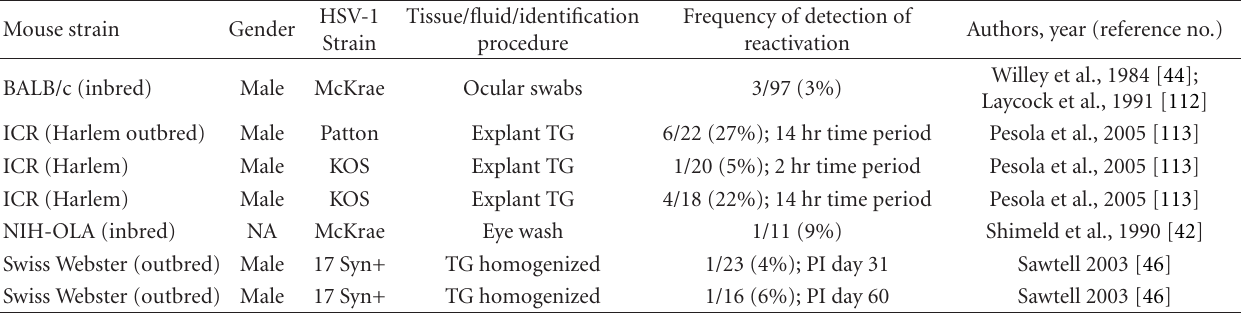
Table 2: Detection of infectious HSV-1 from eye swabs—spontaneous shedding in noninduced mice. Mouse